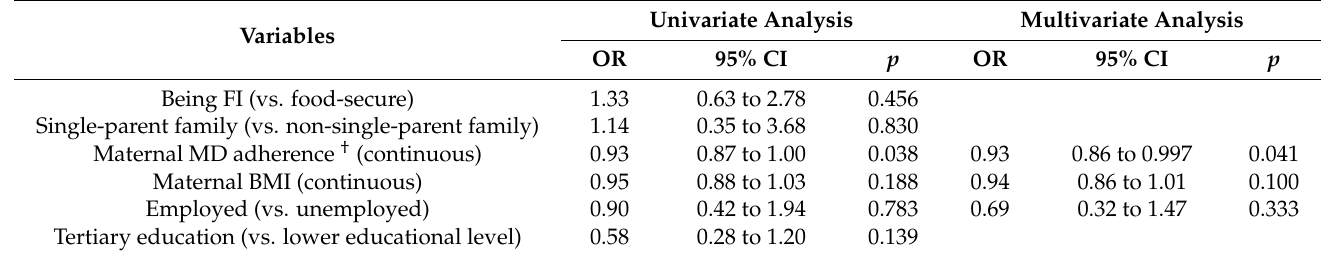
Table 4. Univariate and multivariate logistic regression models explaining children’s MD adherence.